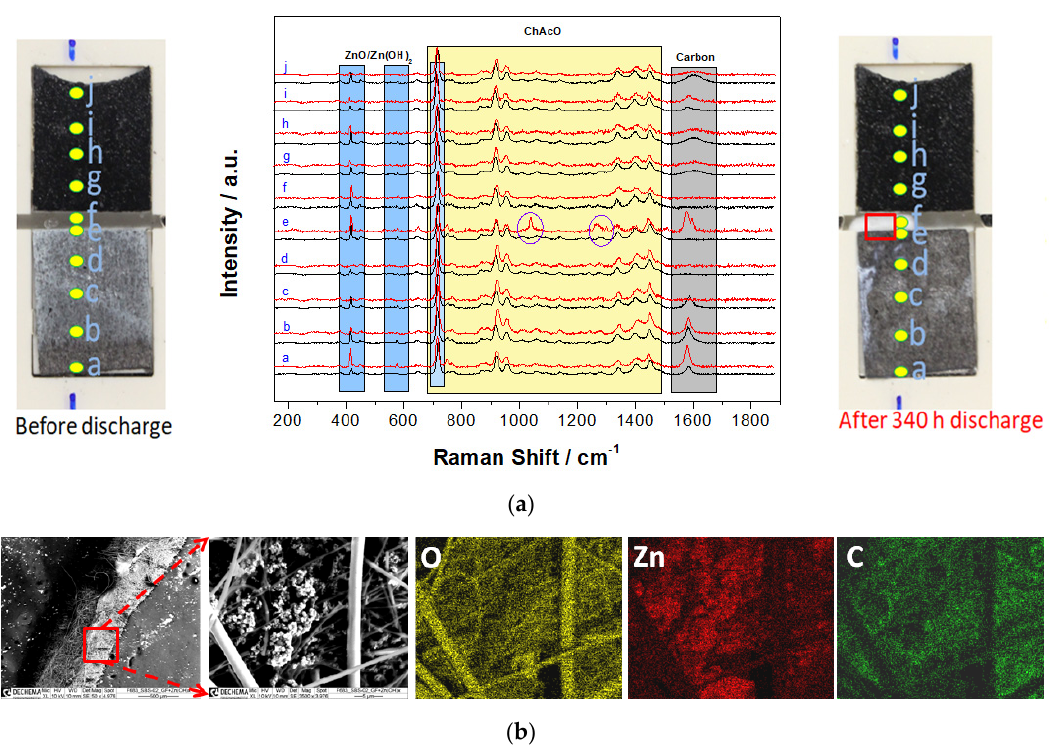
Figure 18. ( a ) Raman line scanning spectra at 10 identical positions of electrodes, separators, and electrolytes with a photo of system set-up (black) before and (red) after the discharge procedure. ( b ) SEM and EDX mapping images of discharge product in glass fiber separator in a red marked square region.